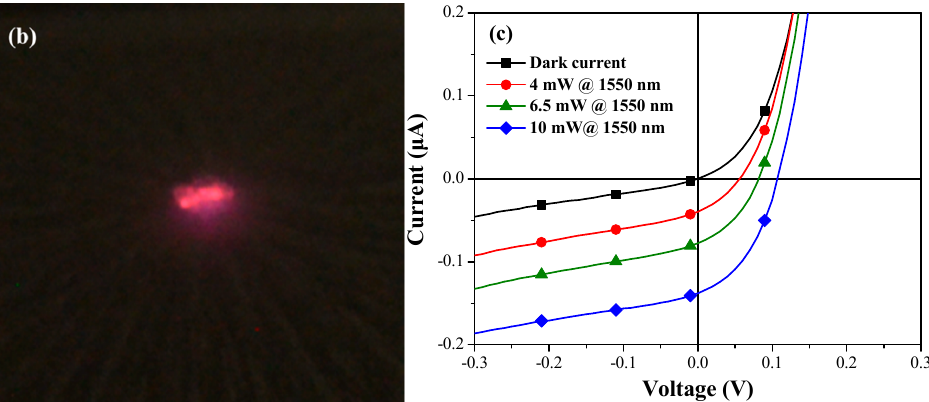
Figure 6. ( a ) Schematic diagram showing measurement set up to estimate up-conversion performance, ( b ) Optical microscope image showing red spot from Yb/Er-doped phosphors illuminated by laser diode with wavelength of 1550 nm and optical power of 5 mW, ( c ) I-V characteristics of proposed silicon solar cell coated with an Yb/Er-doped phosphors layer under dark illumination conditions using 1550 nm light source of variable power.